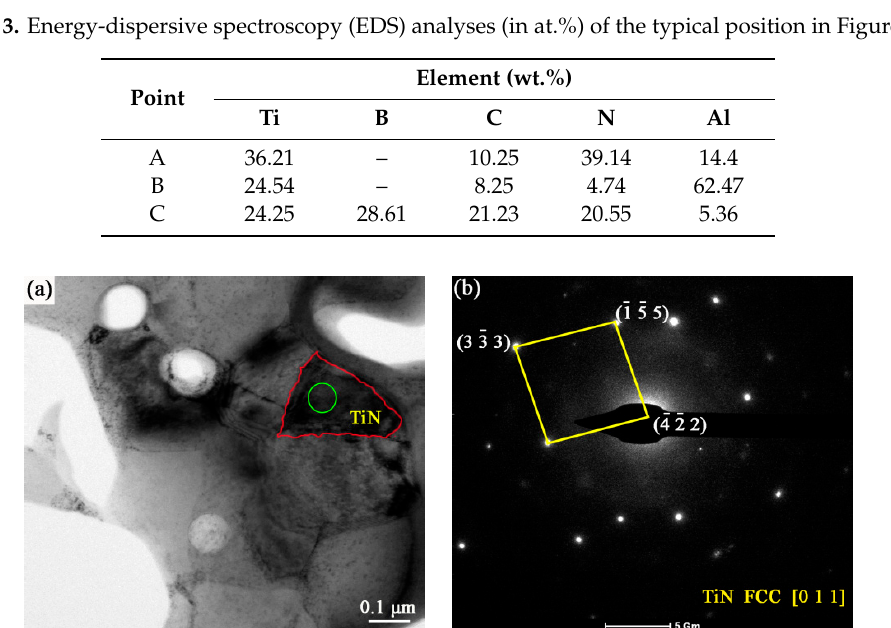
Figure 12. Bright-field TEM images of ( a ) reinforced particles and ( b ) selected area electron diffraction patterns.